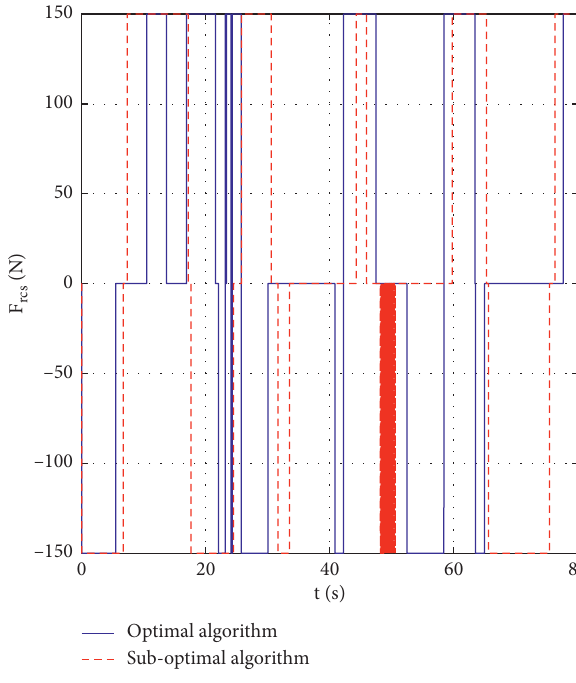
Figure 12: Curve of F